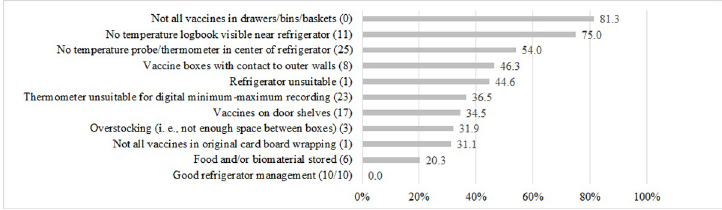
Fig 2. Frequencies for the 10 quality criteria for ’good refrigerator management’ (N = 75). (missing